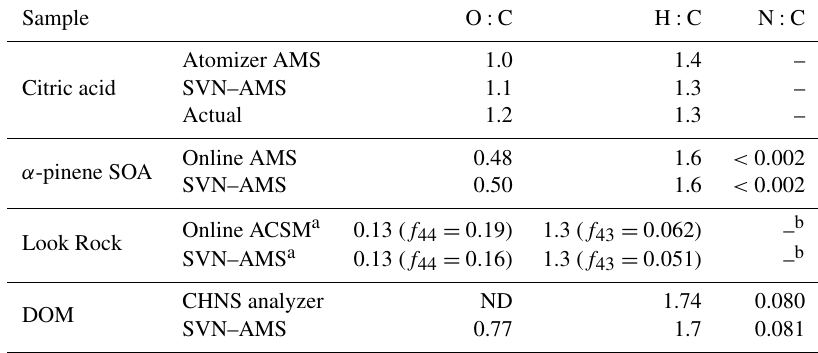
Figure 5. Online (or TSI atomizer) (black) vs. SVN nebulizer (orange) mass spectra for (a) an aqueous solution of citric acid at 1gL − 1 , (b) α -pinene + O 3 chamber SOA, and (c) a SOAS campaign sample from Look Rock, TN, with online data collected on an ACSM. Smaller insets in (a) , (b) , and (c) show direct comparison of intensities for each mass spectrum on a log scale. (d) AMS mass spectra from North Pacific Ocean dissolved organic matter (polysaccharide fraction) nebulized with the SVN (since this sample was not from aerosol particles, no online samples are available). Table 1. Elemental ratios measured by SVN–AMS vs. other techniques for the various mixtures examined in this work. Sample O : C H :